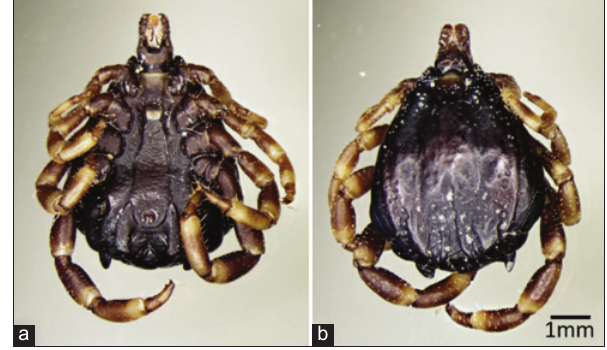
a Figure-2: Camel tick Hyalomma dromedarii ( Acari : Ixodidae ) adult male: (a) Ventral and (b) dorsal.